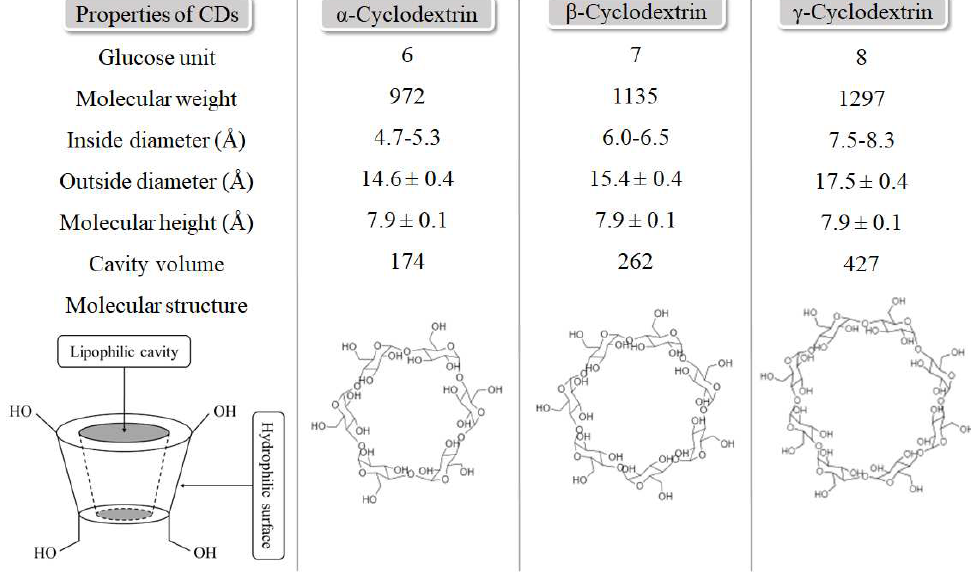
Figure 1. Properties and structures of cyclodextrins.